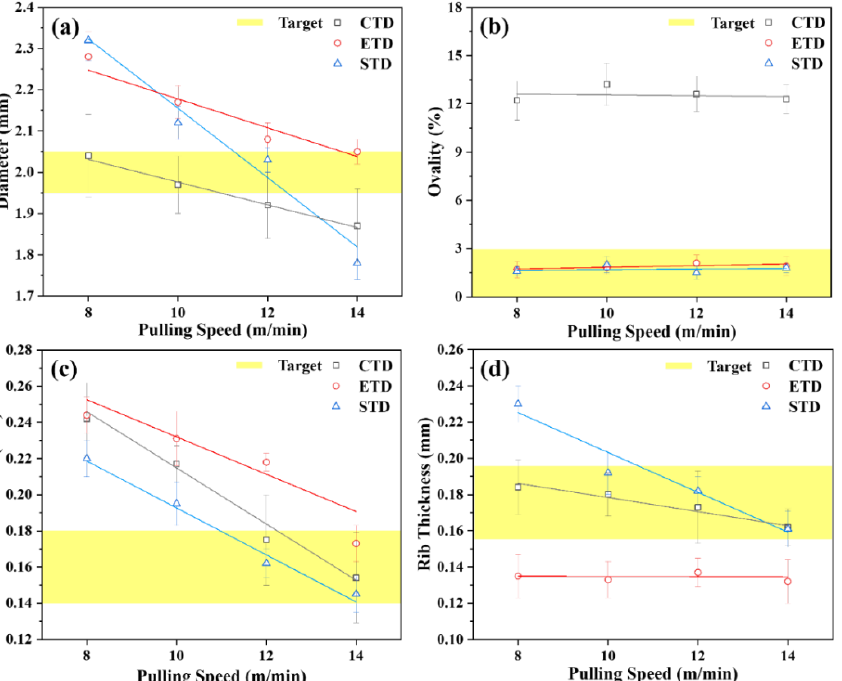
Figure 6. Measurement result of various dimensional parameters according to variable pulling speed for each design model: ( a ) Average outer diameter; ( b ) ovality; ( c ) wall thickness; and ( d ) rib thickness.